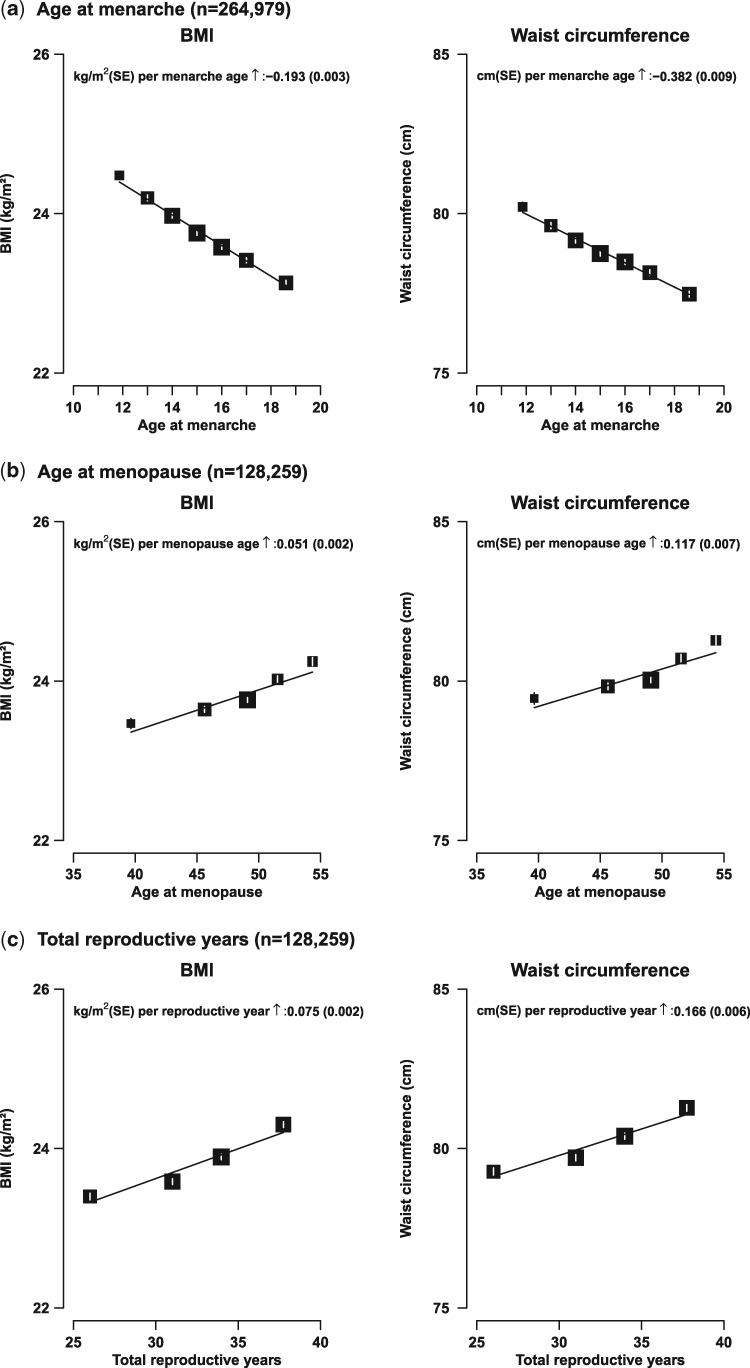
Body mass index (BMI) and waist circumference (WC) vs age at menarche among all women, age at menopause and total reproductive years among post-menopausal women only. The means of each anthropometric measure was adjusted for age, region, education, household income, smoking, alcohol and physical activity. Analyses of age at menopause and reproductive years were only conducted among post-menopausal women, with additional adjustment for other reproductive factors. Closed squares represent the means of anthropometric measures with area inversely proportional to the variance of the mean and the vertical lines represent the corresponding 95% confidence intervals.